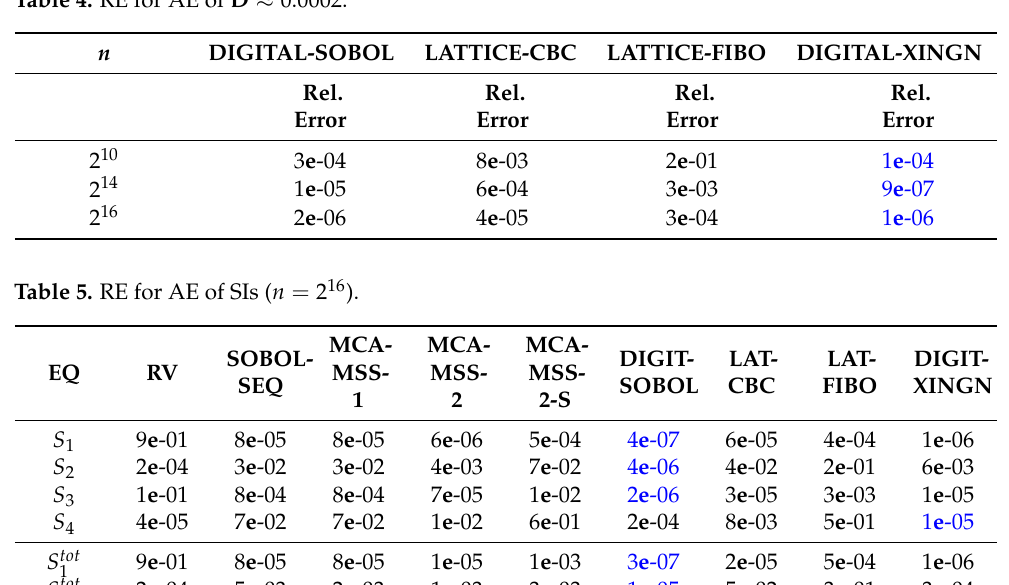
Table 4. RE for AE of D ≈ 0.0002.